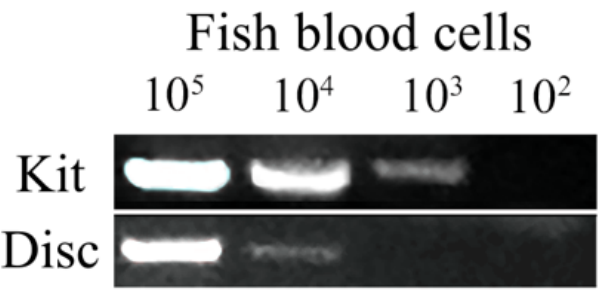
Figure 3. Cellulose-based paper outperforms a commercially available DNA extraction system in fish blood samples. DNA was extracted from different amounts of blood cells from crucian carp (10 5 to 10 2 ) by our disc method or ONE-4-ALL Genomic DNA Mini-Preps Kit (BBI). The eluted DNA was used in a PCR reaction with primers designed for the 16s rRNA gene.